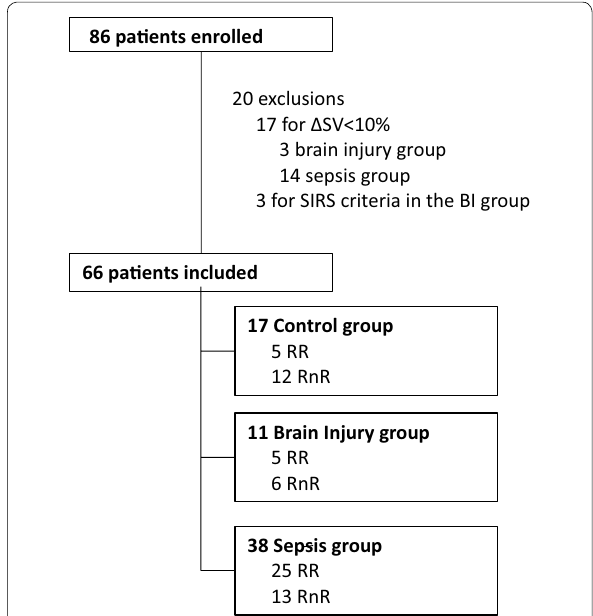
Fig. 1 Flowchart of the study. ∆SV: stroke volume variation before and after fluid loading test; RR: responders–responders (∆SV > 10% and ∆MAP > 5%); RnR: responders–non-responders (∆SV > 10% and ∆MAP <